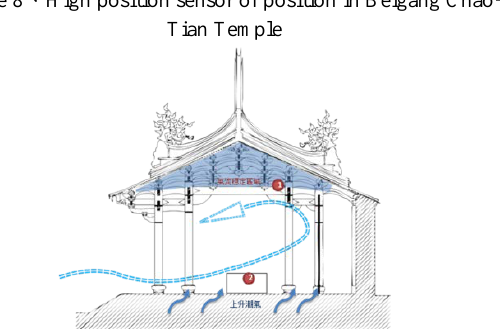
Figure 9 、 Airflow distribution map in Beigang Chao-Tian Temple